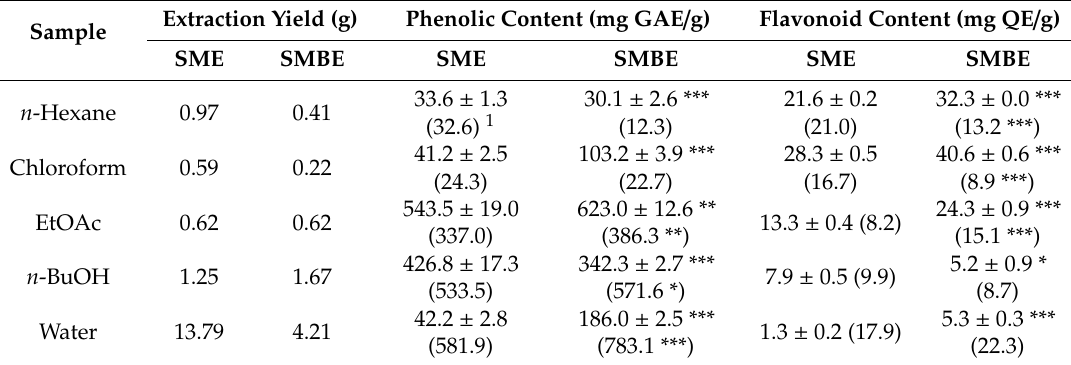
Table 1. Extraction yield and phenolic and flavonoid content of each solvent fraction of non-fermented (SME) and fermented (SMBE) roots of S. miltiorrhiza